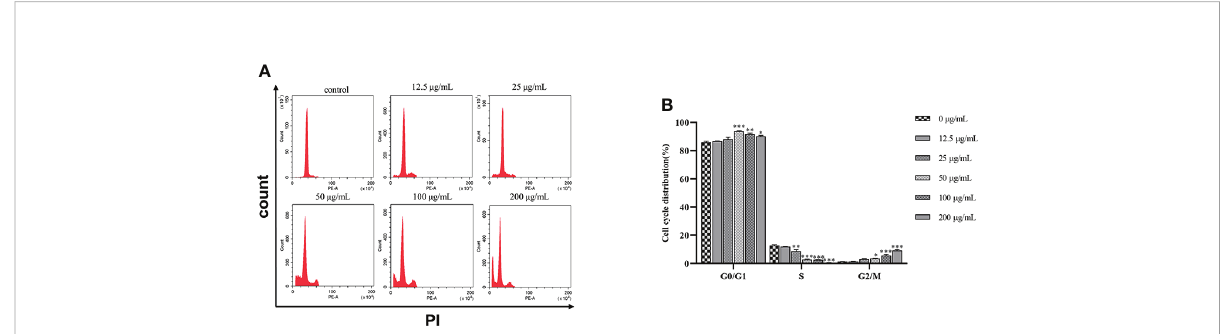
FIGURE 6 Effects of 1,2,3,4,6-pentagalloyl- b -D-glucose on the SGC7901 cell cycle. (A) Intracellular fl uorescence intensity of SGC7901 cells cultured with 1,2,3,4,6-pentagalloyl- b -D-glucose (0, 12.5, 25, 50, 100, and 200 µg/ml) for 48 (h) (B) Average fl uorescence intensity of SGC7901 cells. * p < 0.05, ** p < 0.01, *** p < 0.001 vs. 0 µg/ml.